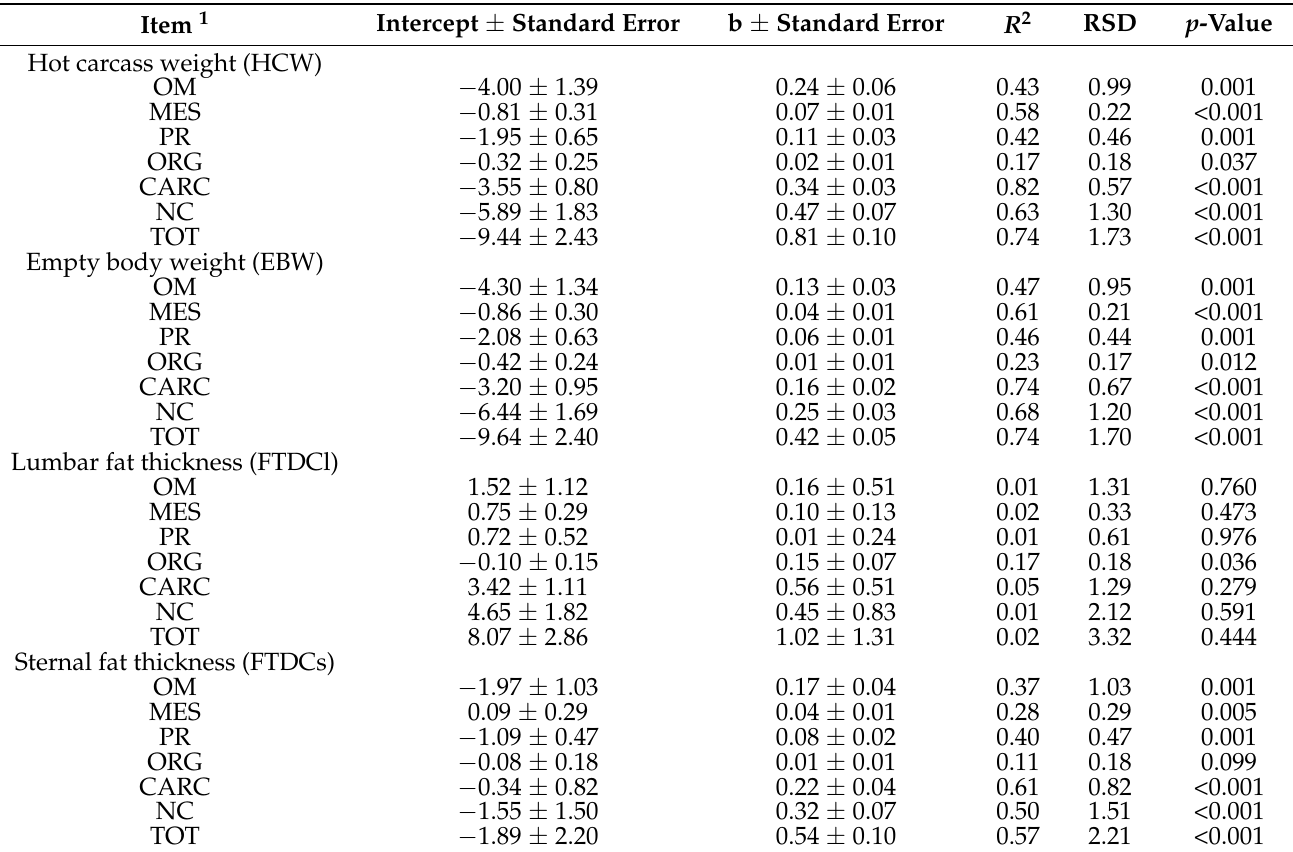
Table 4. Regression equations (y = a + bx), coefficient of determination ( R 2 ), and residual standard deviation (RSD) values for estimate of the different fat depot weights (kg) and the total weight of all fat combined (y variables) based on the post-slaughter measurement values hot carcass weight (HCW), empty body weight (EBW), and lumbar and sternal fat thickness depths measured by a digital caliper (FTDCl and FTDCs, respectively) (x